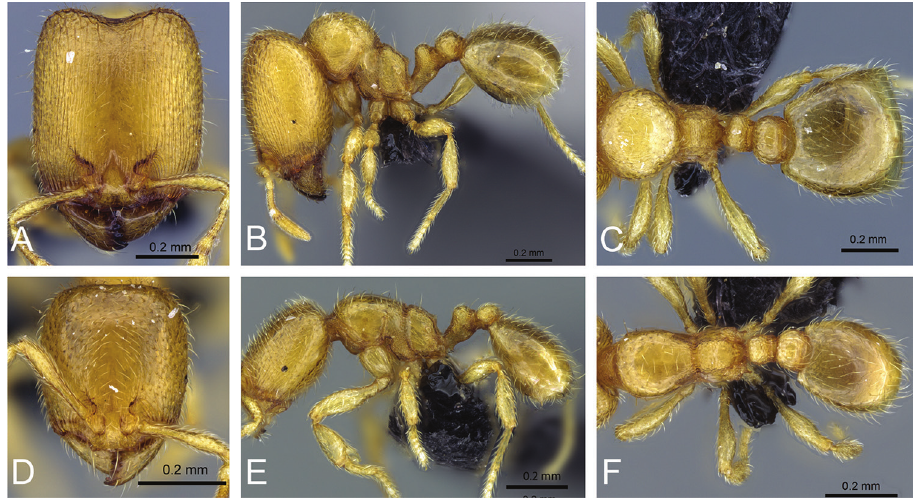
Figure 52. Carebara nosindambo , Major worker, CASENT0073096: A head in full-face view B body in profile view C body in dorsal view. Minor worker, CASENT0073105: D head in full-face view E body in profile view F body in dorsal